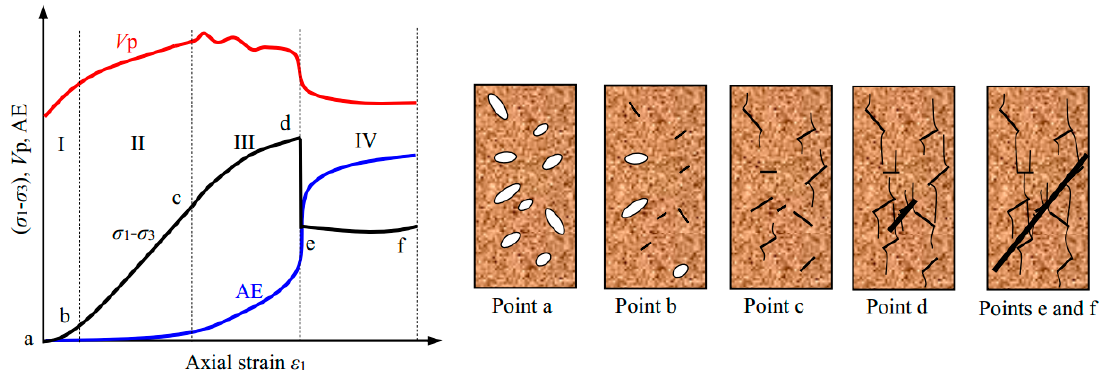
Figure 15. A sketch for the evolution of P-wave velocity and accumulated AE counts of rock specimens during conventional triaxial failure process.